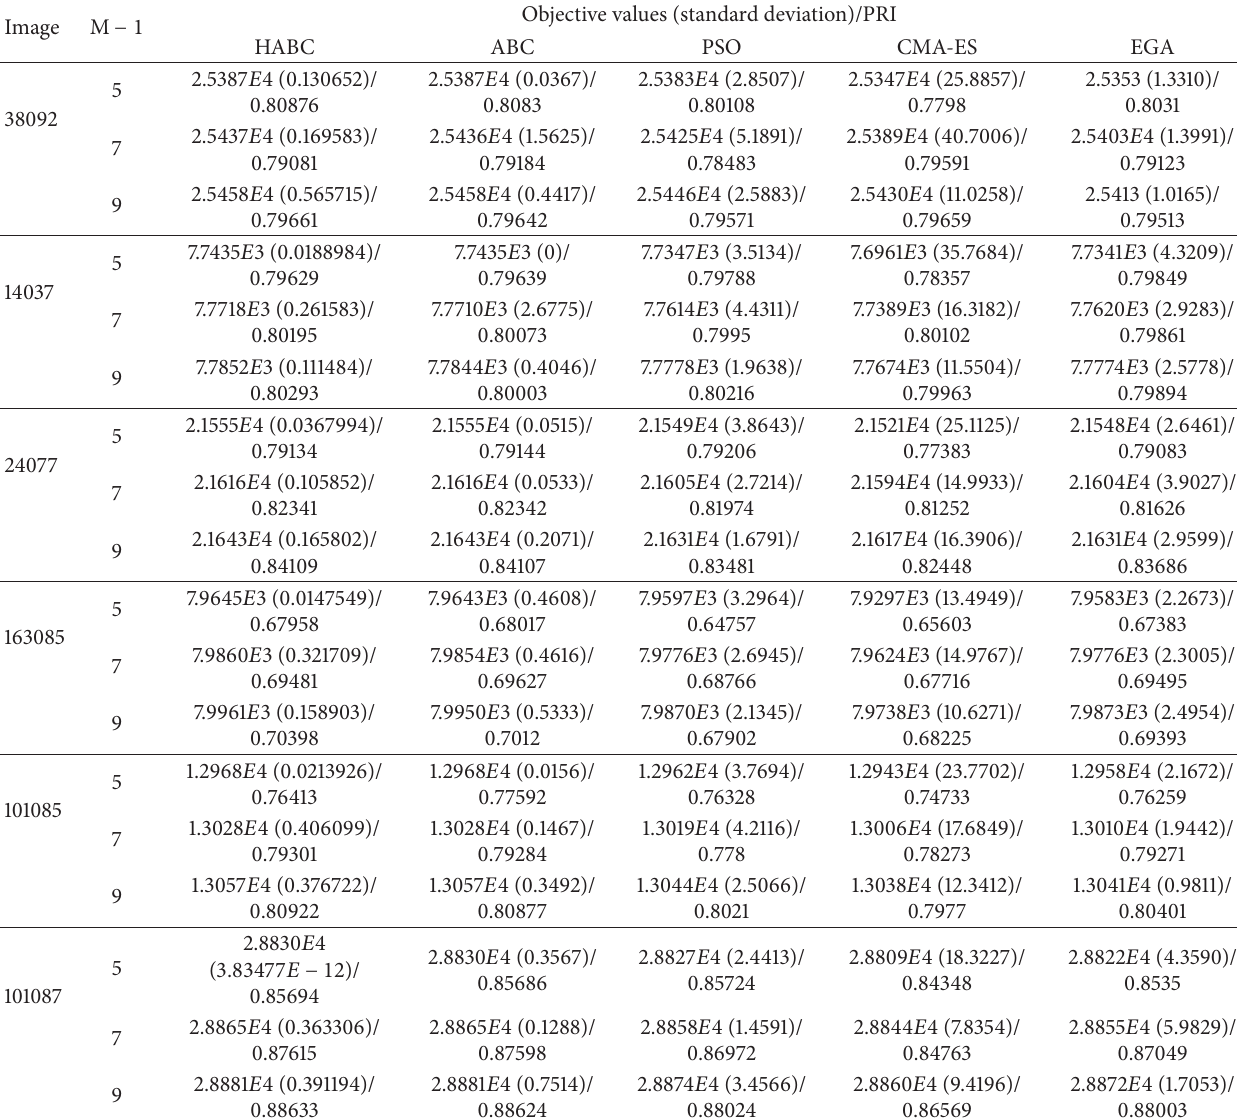
Table 10: Objective value, standard deviation, and PRI by the compared population-based methods on Otsu algorithm.